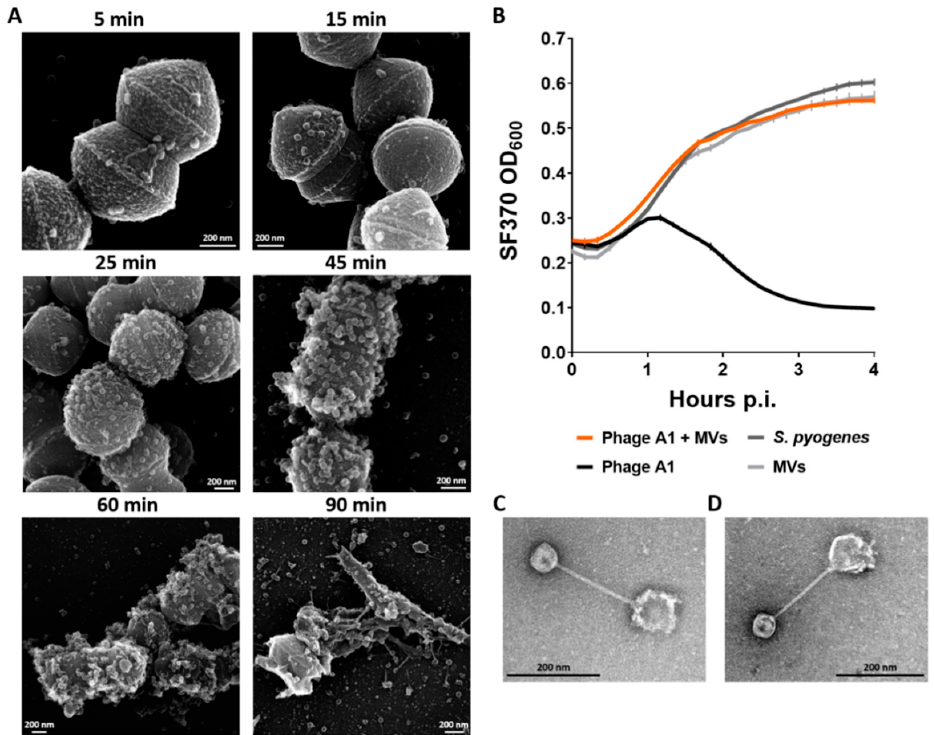
Figure 6. S. pyogenes -derived membrane vesicles inhibit phage infection. ( A ) Representative SEM micrographs of S. pyogenes SF370-infected with Phage A1 at MOI 10 are shown after 5, 15, 25, 45, 60 and 90 min of coincubation; ( B ) Growth curves of WT SF370 after Phage A1 infection that was either pre-incubated with membrane vesicles (MVs) or left untreated. Phage: S. pyogenes :MV ratio of 1:1:1000 is shown. Mean values ± SD from one out of three independent experiments in Table 1. bound to a S. pyogenes SF370-derived MV; ( D ) TEM micrograph of a S. pyogenes ISS3348-derived MV bound to Phage A1; ( C , D ) Representative images are shown for at least three sample preparations.